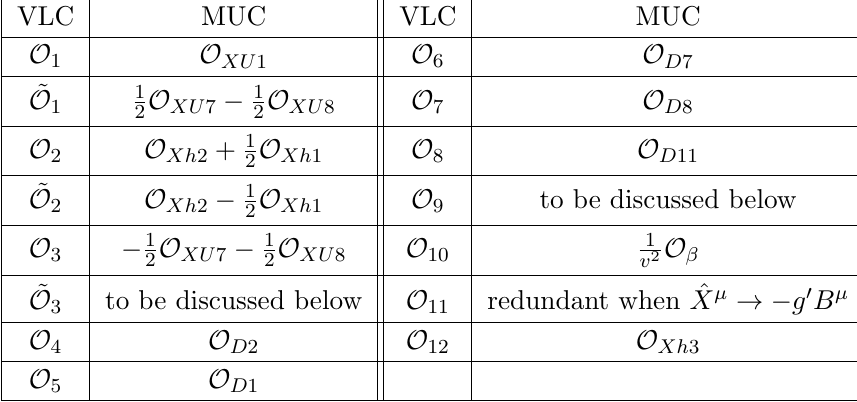
Table 7 . Dictionary of bosonic